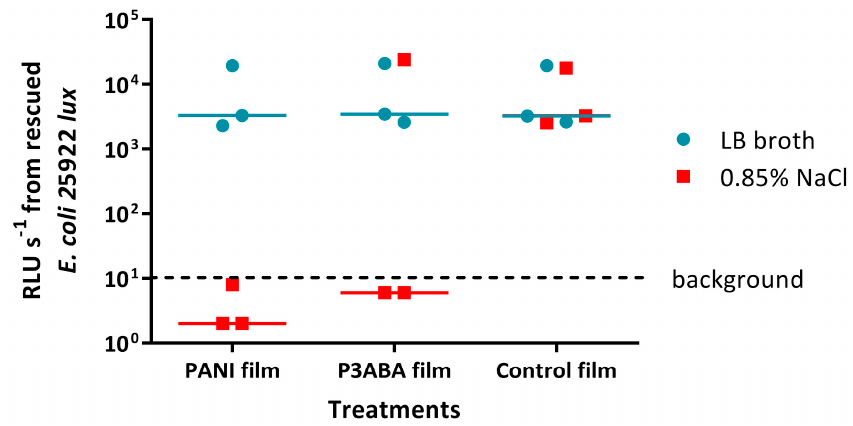
Figure 8. Activity of PANI and P3ABA films against E. coli 25922 lux in the presence and absence of organic matter. ~10 4 CFU of E. coli in 10 µ L LB broth or 10 µ L 0.85% saline was sandwiched between two pieces of PANI film, P3ABA film, or control film for 2 h. The cells were rescued by washing the film samples with LB broth and transferred to a 96 well plate. The rescued cells were incubated at 37 ◦ C for 16 h and light release was measured. The vertical axis shows the bioluminescence measurements (RLU s − 1 ) from the recovered cells with each data point representing an independent experiment and the line representing the median. Background luminescence readings are ~10 RLU s − 1 .